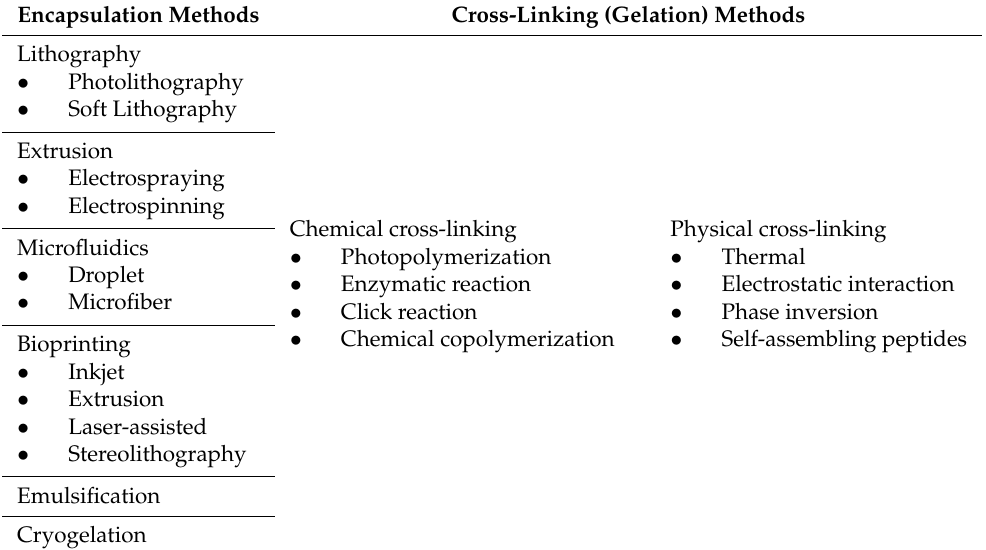
Table 3. Key encapsulation and gelation